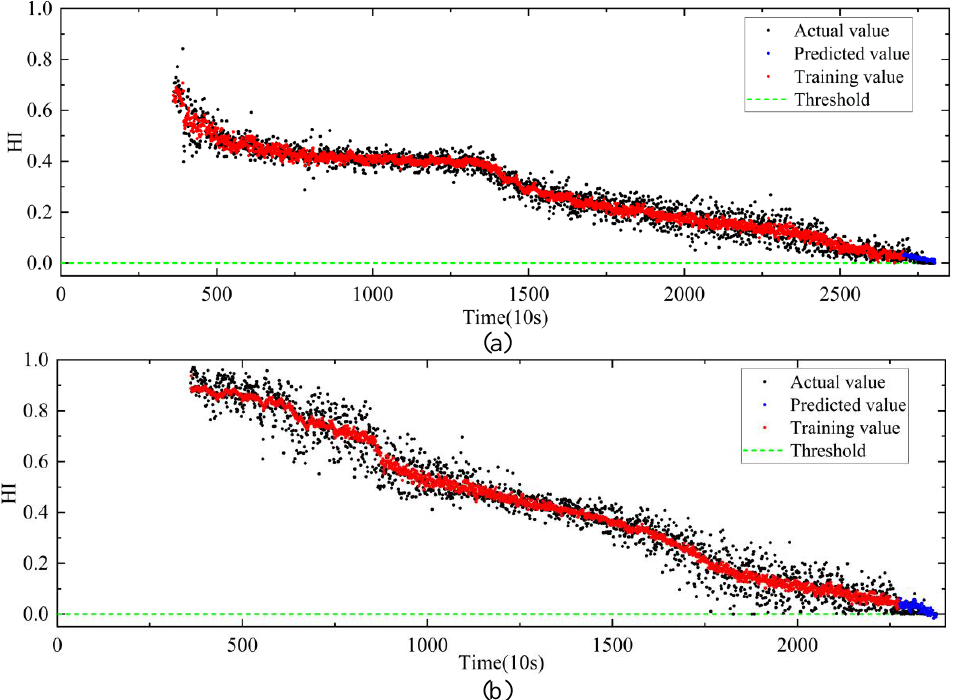
Figure 12. RUL prediction results of MSCAE-HI. ( a ) Bearing1_1. ( b ) Bearing1_3.